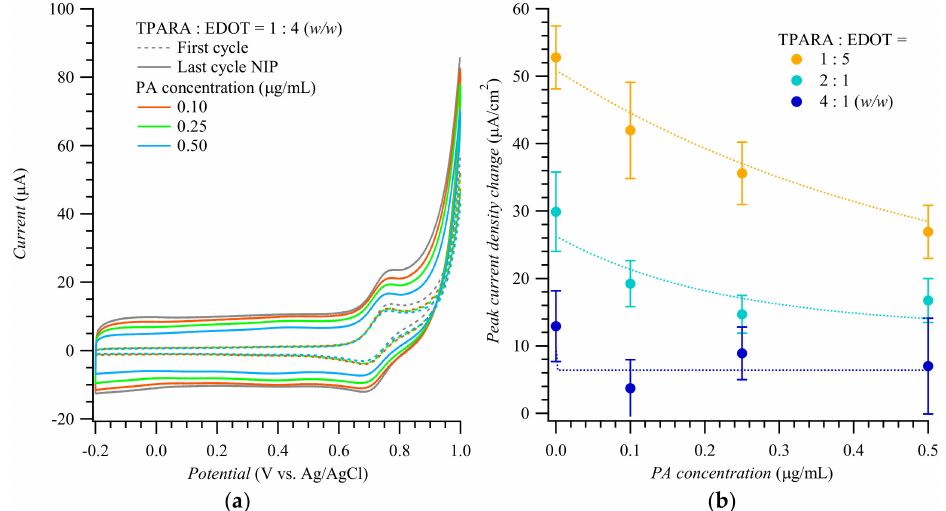
Figure 1. ( a ) Potentiodynamic curves of the 1st and 20th cycle during simultaneous electropoly- merization and deposition of PA-templated MIP films for different concentrations of the peptide A template. ( b ) The difference in the peak current of the 20th and 1st polymerization cycle, for different TPARA-to-EDOT ratios, vs. PA template